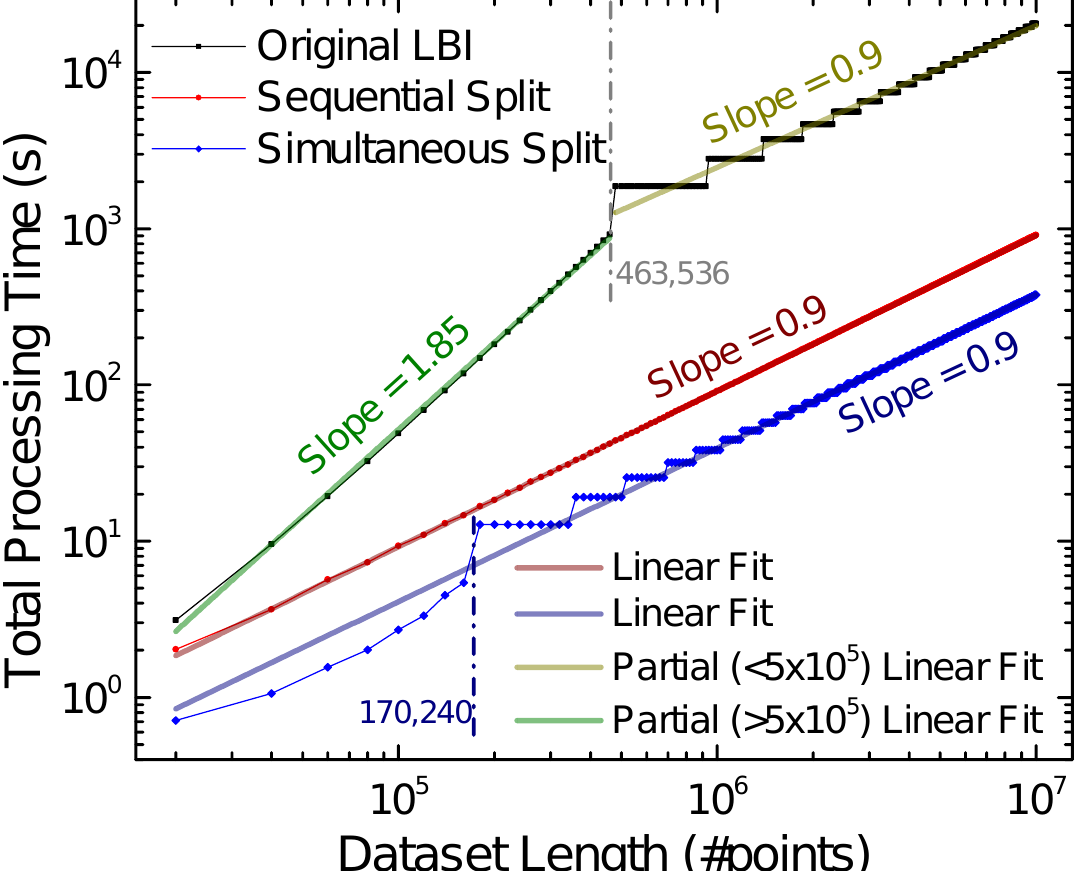
Figure 7. Total processing time as a function of the dataset length for three possible hardware implementations in the S TRATIX V. The results are displayed in LOG - LOG scale for ease of visualization. Striking features, discussed in the text, are: the slope break of the original LBI curve, which corresponds to the transition to batch processing; the equivalence between the asymptotic slopes of all three curves; and the dominance of the simultaneous split-profile hardware in terms of processing time over the other